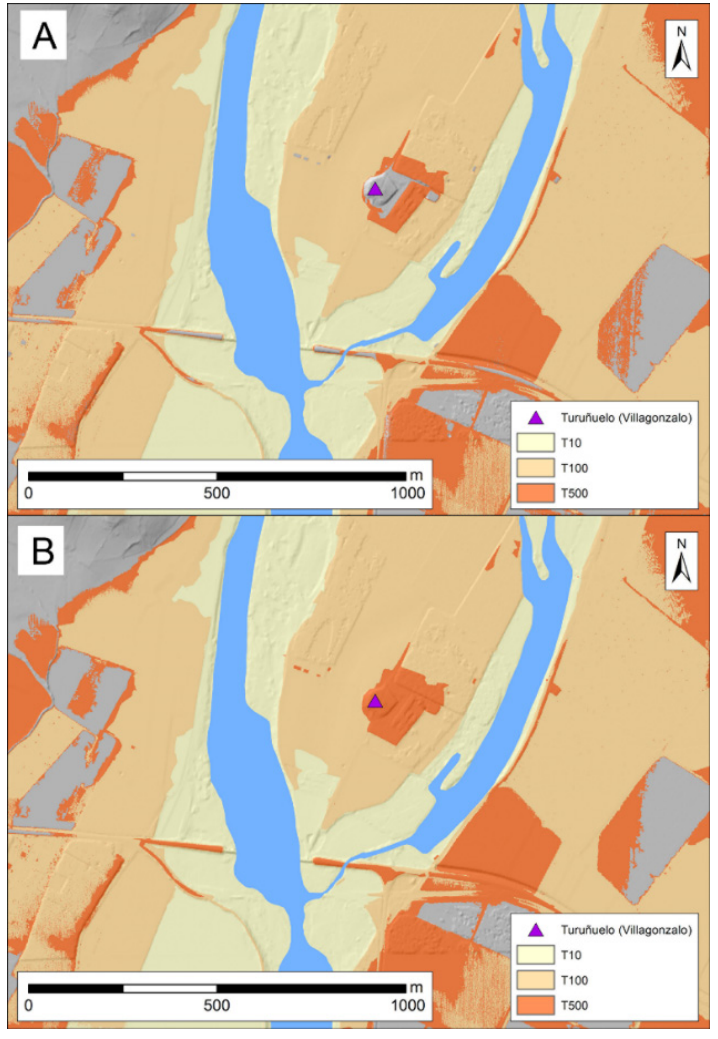
Figure 8. APSFR analysis corresponding to the territory where the Turuñuelo tumulus is located (Villagonzalo, Badajoz, Spain). ( A ) Calculation of APSFR zones prior to the reclassification of the land. ( B ) Representation of the territory affected by the APSFR zones after reclassification of the terrain and correction of the distortions.